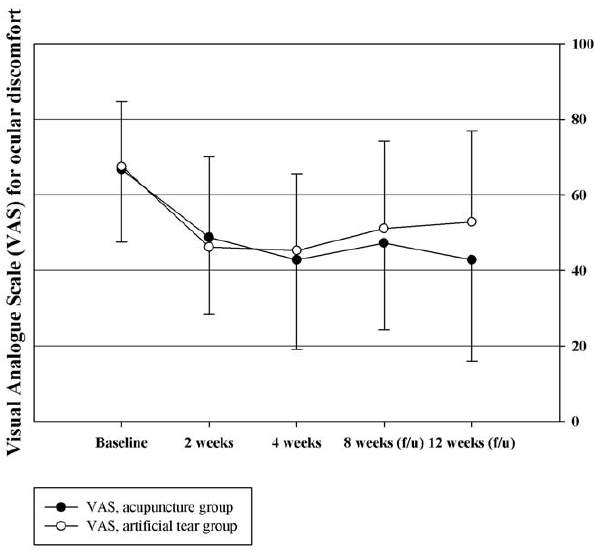
Figure 3. Visual analogue scale (VAS) for self - assessment of ocular discomfort.